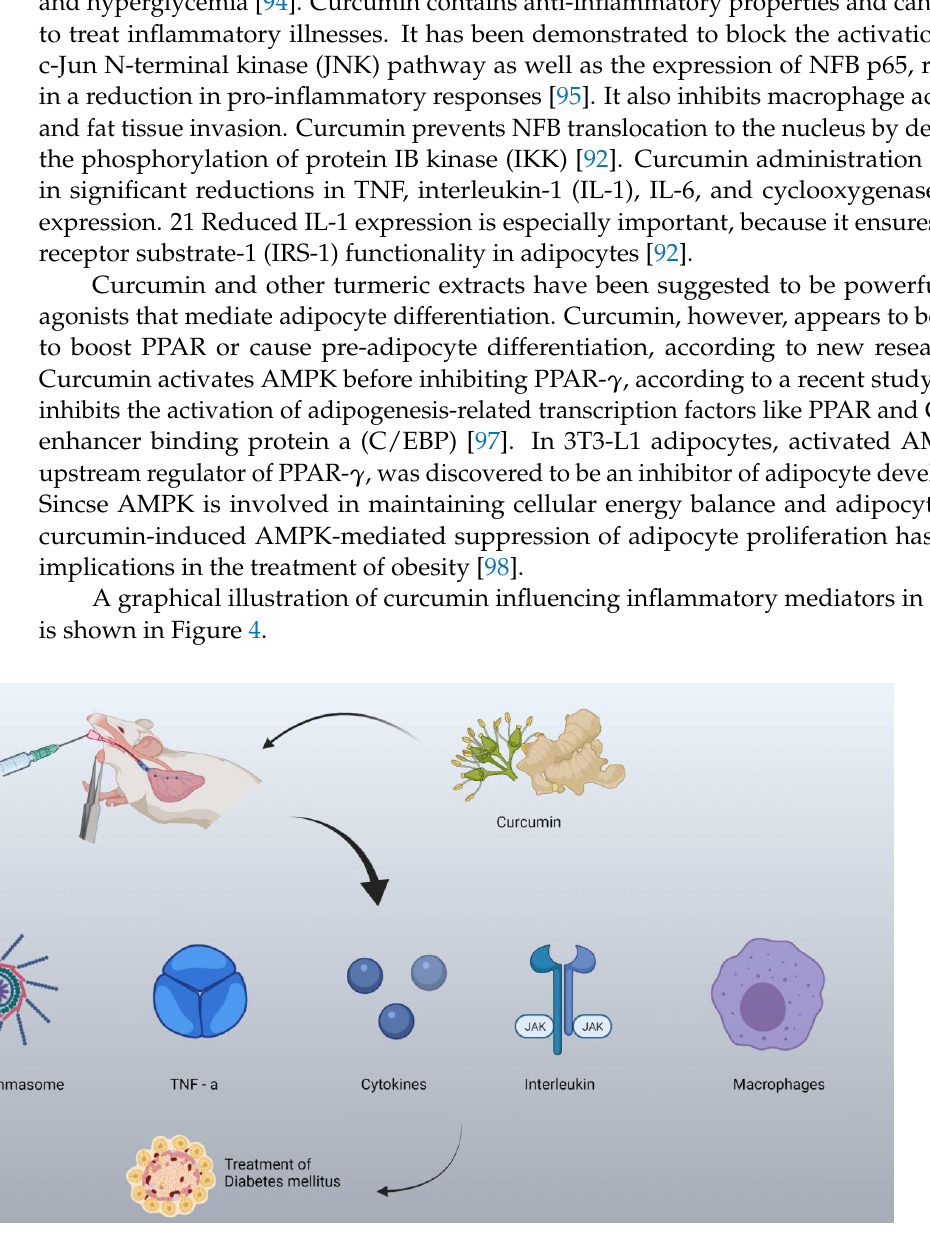
Figure 4. Curcumin targeting various inflammatory mediators in diabetes mellitus.